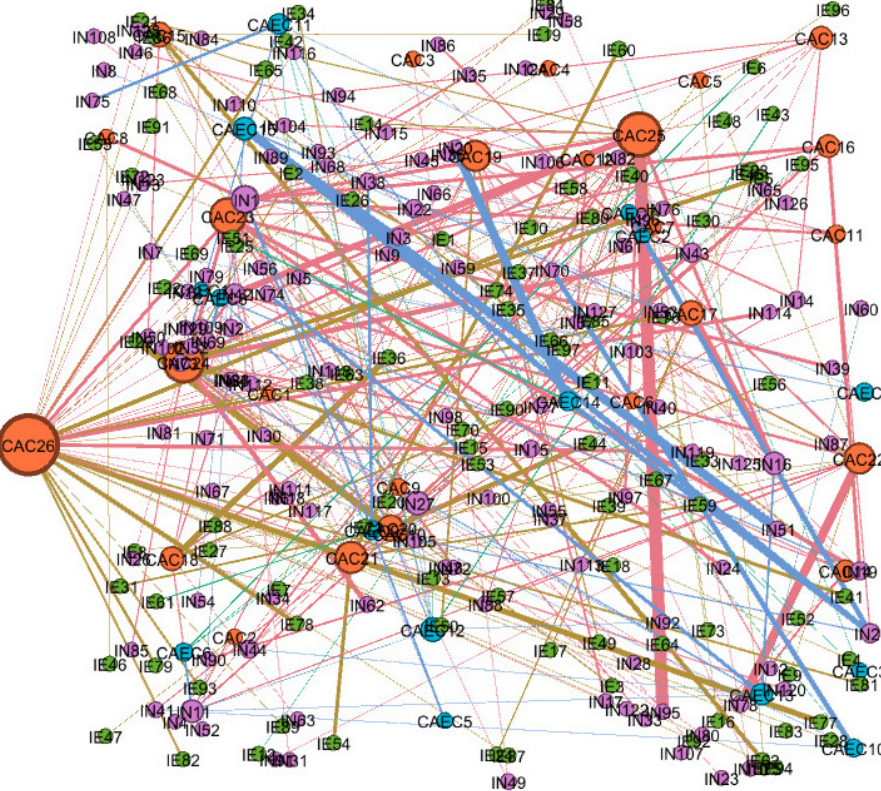
Fig. 4. Graph of representation of the scienti¯c collaboration of the research groups in the